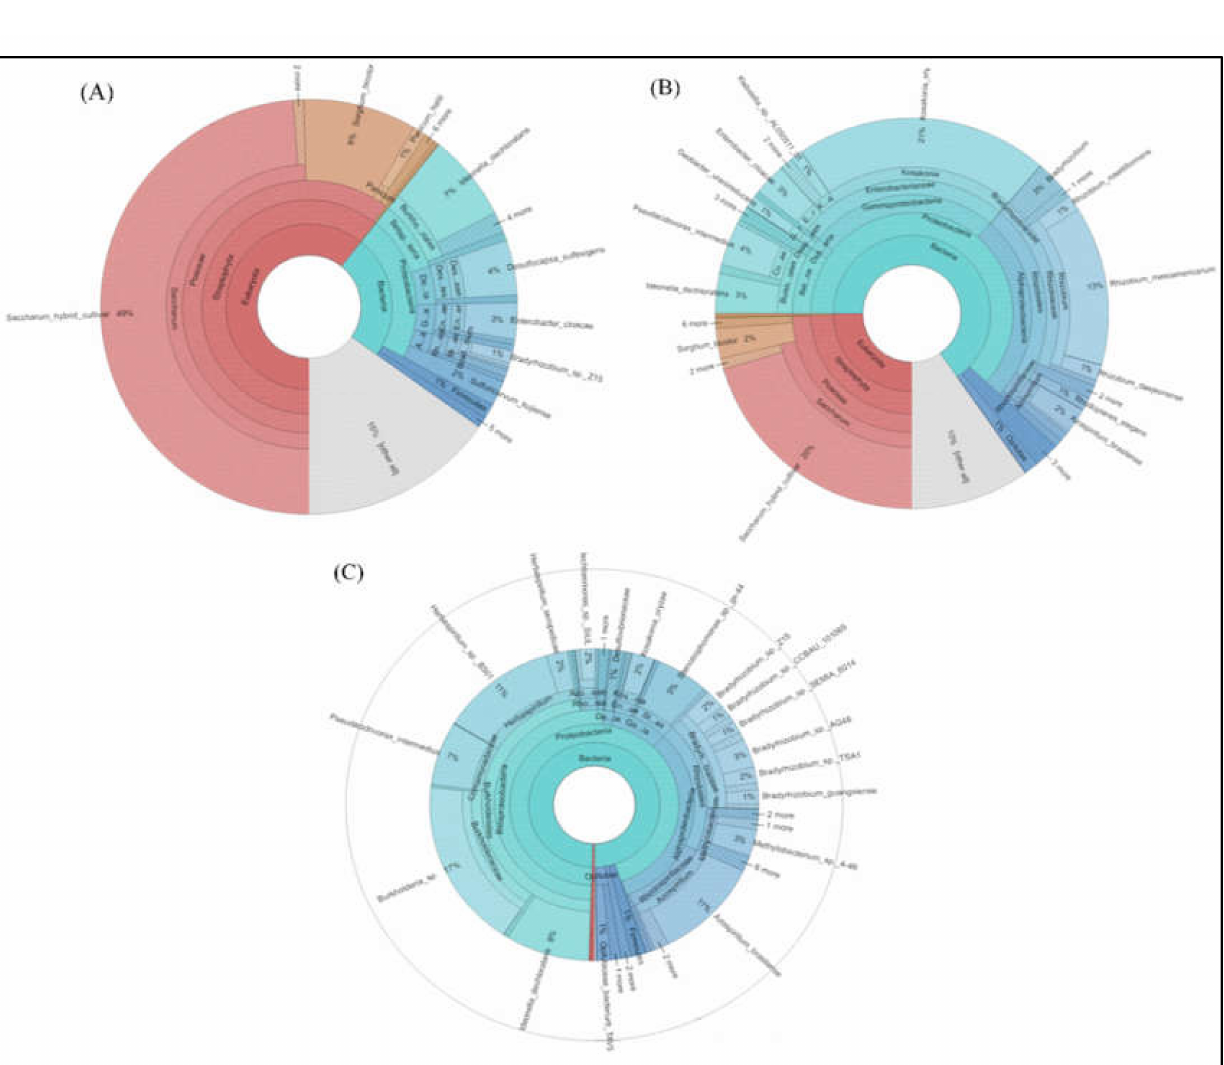
Figure 3. Krona software results show results of species annotations of ( A ) leaf, ( B ) stem, and ( C ) root samples. In the display results, the circles represent different classification levels from the inside to the outside, and the size of the fan represents the relative proportion of different OTU annotation